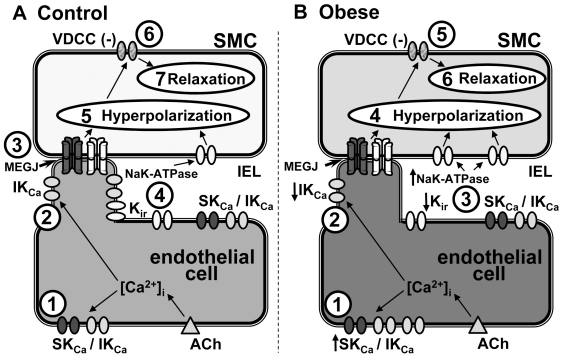
Model EDH mechanism.In arteries from control (A), agonist (ACh) elicits increased endothelial [Ca2+]i and subsequent endothelial membrane SKCa and IKCa activation (1), including at IKCa densities at potential myoendothelial gap junction (MEGJ)-related microdomain signaling sites (2). The resulting endothelial hyperpolarization can spread to the smooth muscle via MEGJs (3). The hyperpolarization is amplified by smooth muscle Na+/K+-ATPase activation and endothelial Kir, following SKCa and IKCa-mediated K+ efflux into the extracellular space (4), some of which are located at potential MEGJ-related signaling domains (
Fig. 5Cii, iii
; see also [13]). Smooth muscle hyperpolarization occurs (5), with closure of voltage-dependent calcium channels (6) and subsequent vessel relaxation (7). In arteries from obese animals (B), SKCa and IKCa are primarily located on the endothelial cell membrane (1); with IKCa incidence at MEGJ-related signaling domains being significantly decreased compared to control (2; Table S1). Since MEGJ incidence is unaltered, and the number of smooth muscle cell (SMC) layers increased in obesity compared to control, MEGJ-dependent EDH transfer may not be a sufficient driving force for smooth muscle relaxation. Under these circumstances, and in the absence of detectable Kir, EDH is primarily attributable to activation of smooth muscle Na+/K+-ATPase, following K+ efflux from primarily endothelial cell membrane SKCa and IKCa (3). Once sufficient hyperpolarization occurs (4), voltage-dependent calcium channels close (5) and relaxation results (6).